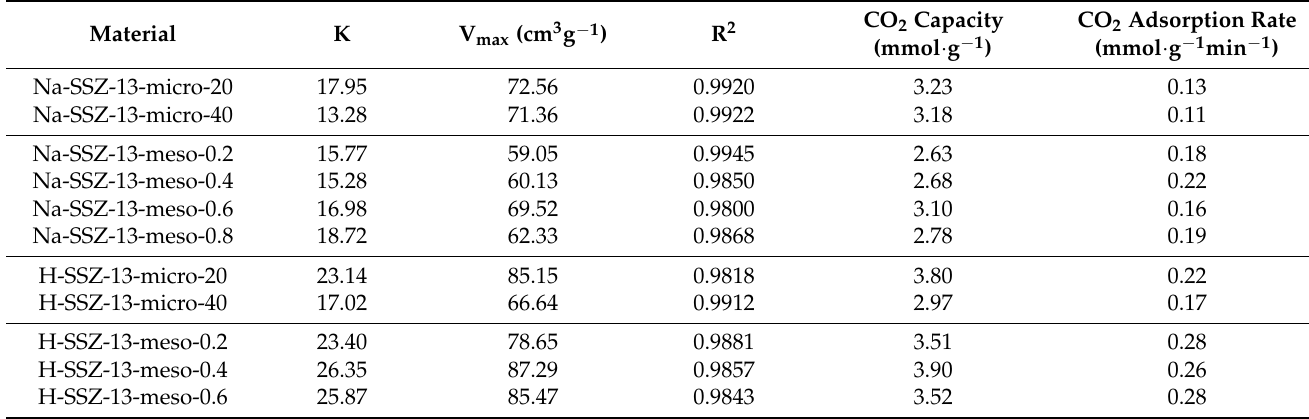
Table 3. CO 2 adsorption capacity and rate and the Langmuir isotherm parameters for microporous and mesoporous